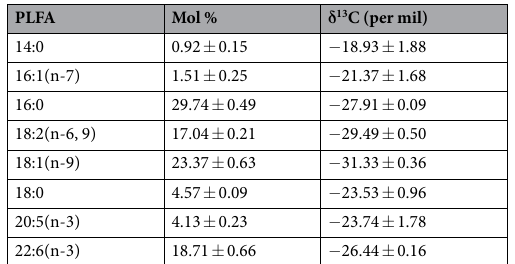
Table 1. Composition and isotopic signatures of phospholipid fatty acids (PLFAs) (average ± SD) in salmon feed pellets (Skretting Label Rouge, 11 mm).